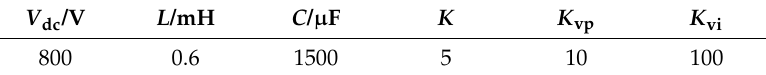
Table 1. Parameters of droop control.